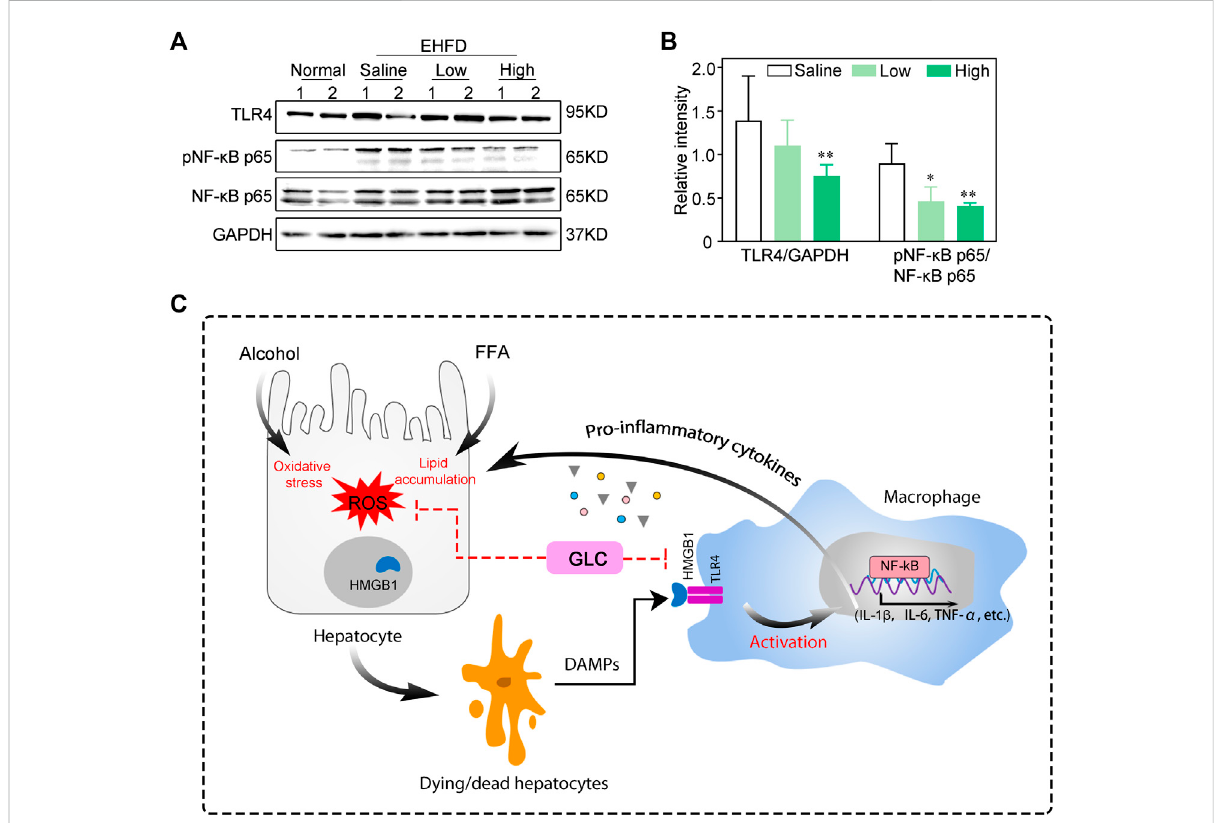
FIGURE 6 GLC ameliorates progression of steatohepatitis via HMGB1-mediated TLR4/NF-KB pathway (A) Western blot analysis of indicated proteins expression. (B) The relative intensity of indicated proteins expression. The data were obtained from three dependent experiments per group. (C) Process of GLC inhibiting HMGB1-mediated macrophage activation by TLR4/NF-KB in the progression of steatohepatitis. Alcoholics and free fatty acids cause oxidative stress injury and lipid accumulation of hepatocytes. The dying/dead hepatocytes release DAMPs - HMGB1 to the extracellular. HMGB1 combined with TLR4 of macrophages to activate the in fl ammatory response through the NF-KB pathway, which